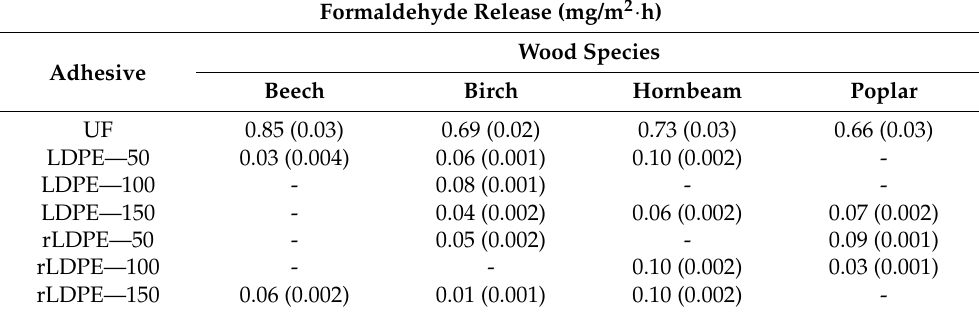
Table 3. Formaldehyde release of plywood